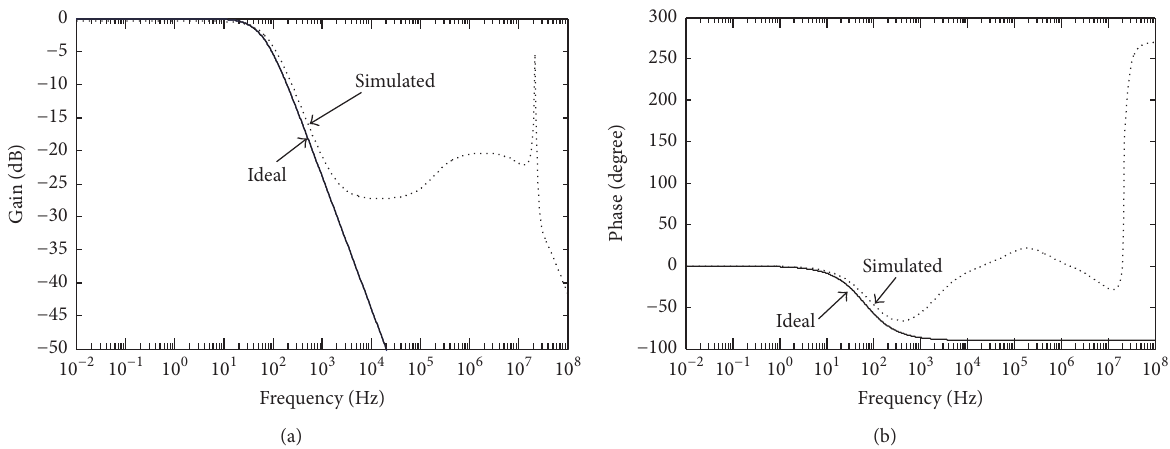
Figure 8: Frequency response for the low pass filter: (a) gain and (b) phase shift.